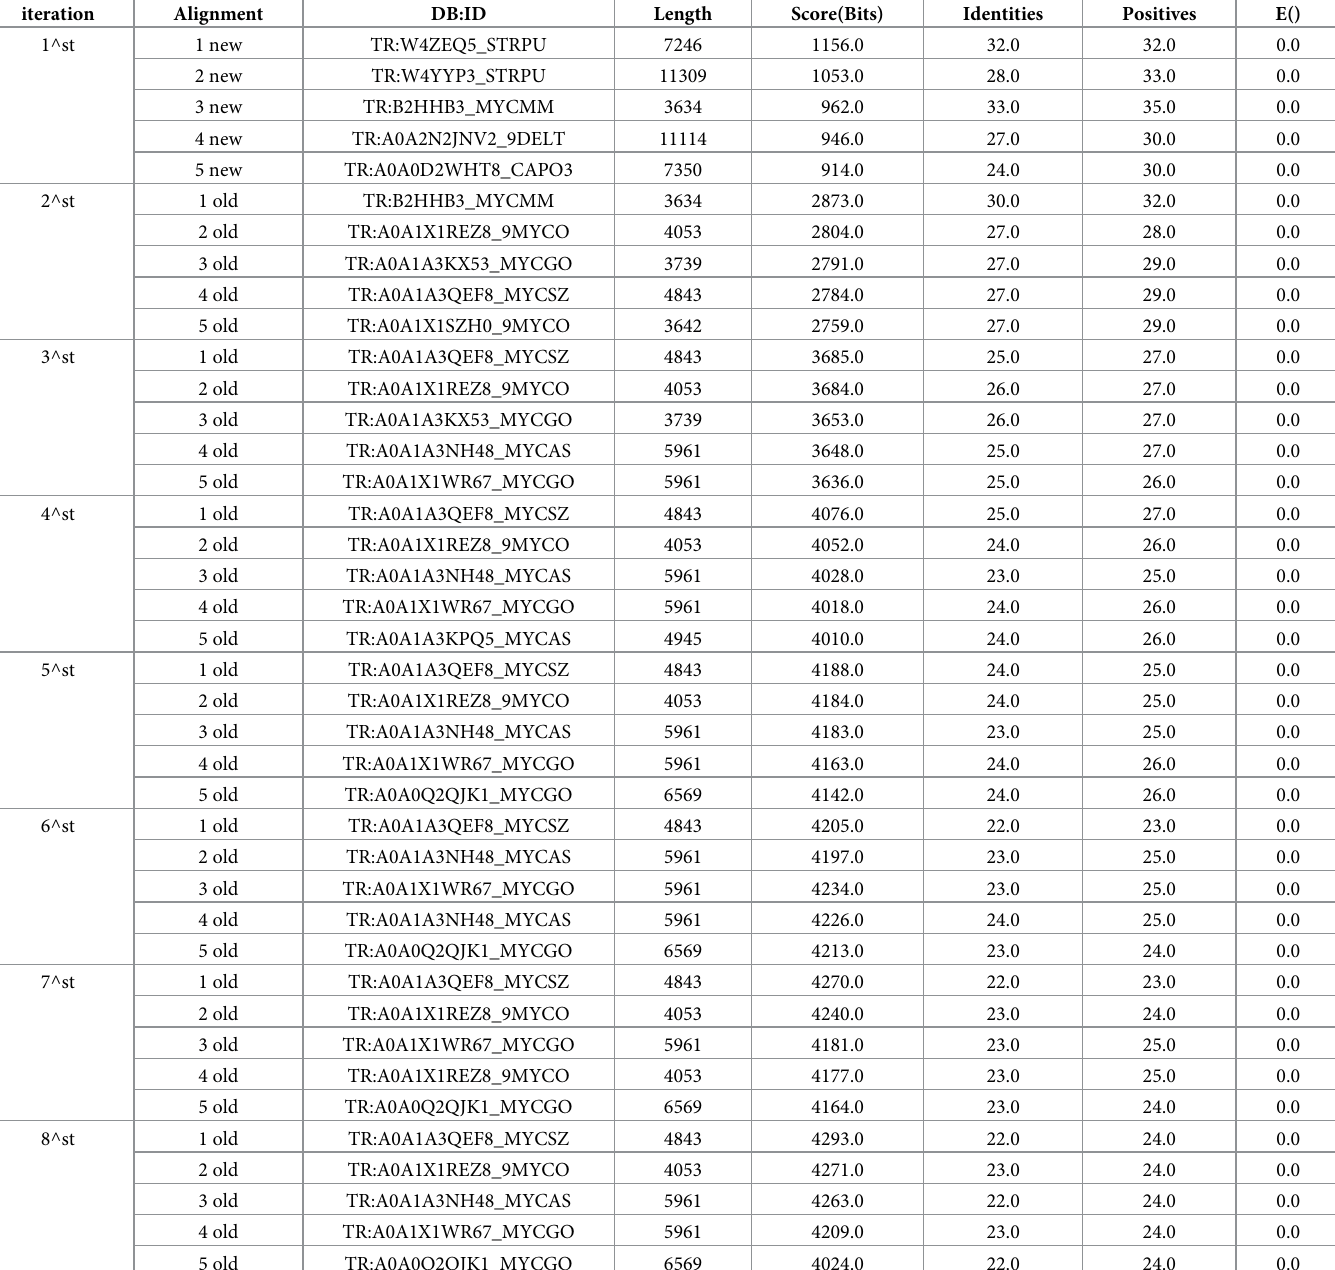
Table 3. The PSI-BLAST search results of the suspected gene sequence 21-21000-24250. It contains the sequence alignment information of the first 5 sequences in the search results of the previous eight iterations. The similar sequences in search results sort descending based on score values.